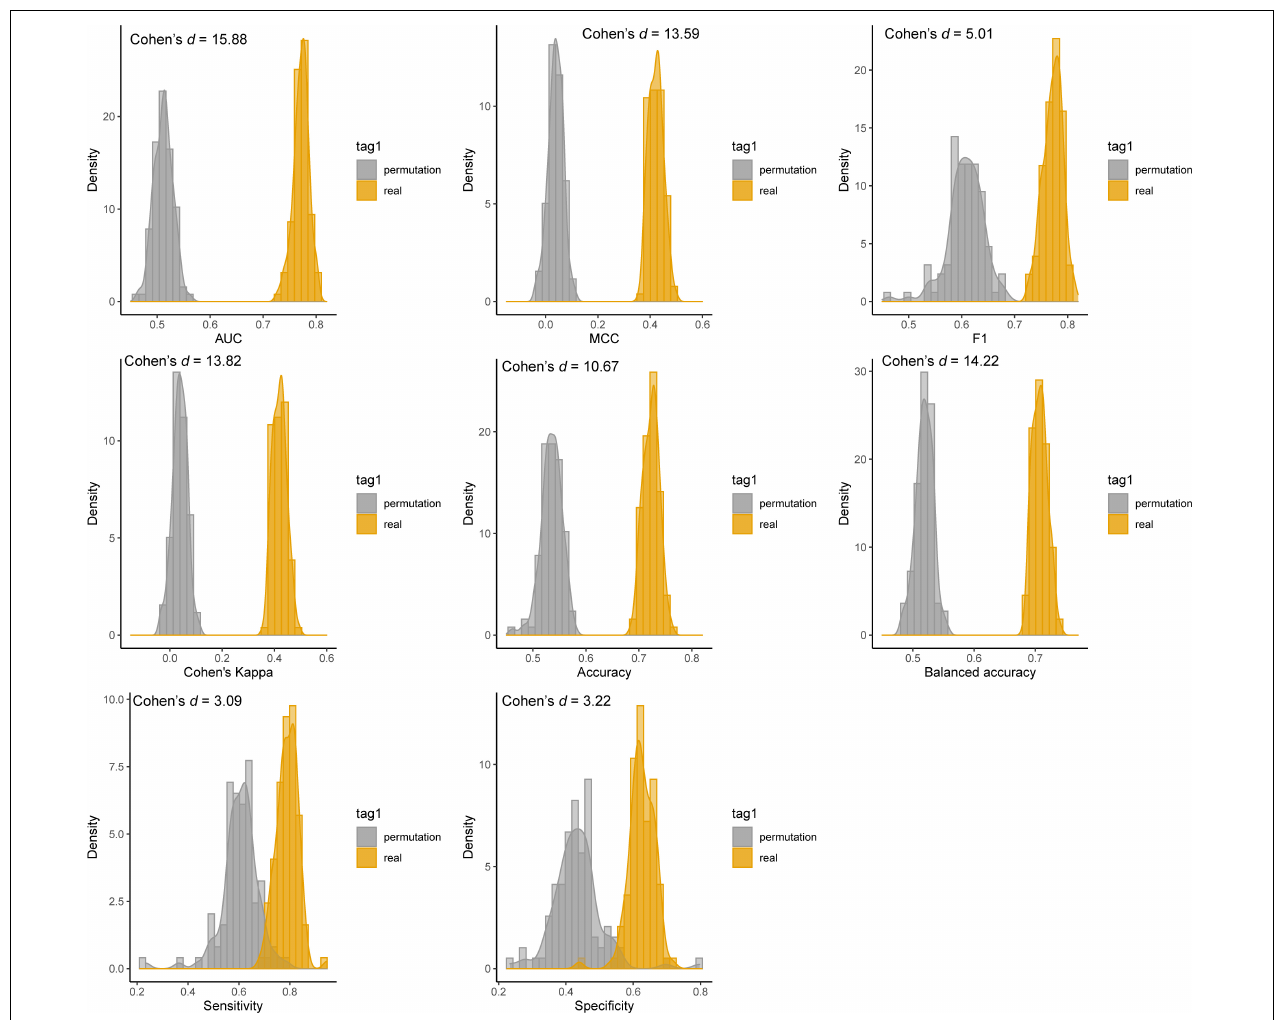
FIGURE 5 | Permutation tests for the developed DNN model: the distributions of the eight performance metrics from 100-iteration MCCV were illustrated. The distributions of DNN models using the real training datasets and Y -scrambled training datasets were denoted with orange and gray colors,